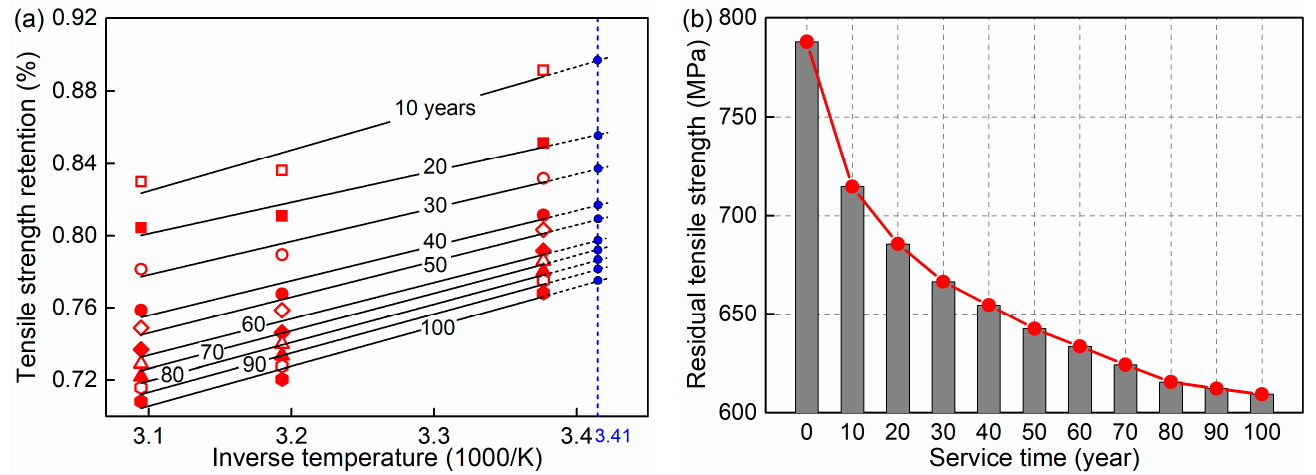
Figure 4. Estimated results of GFRP bar deterioration: ( a ) Arrhenius curves; ( b ) residual tensile strength.